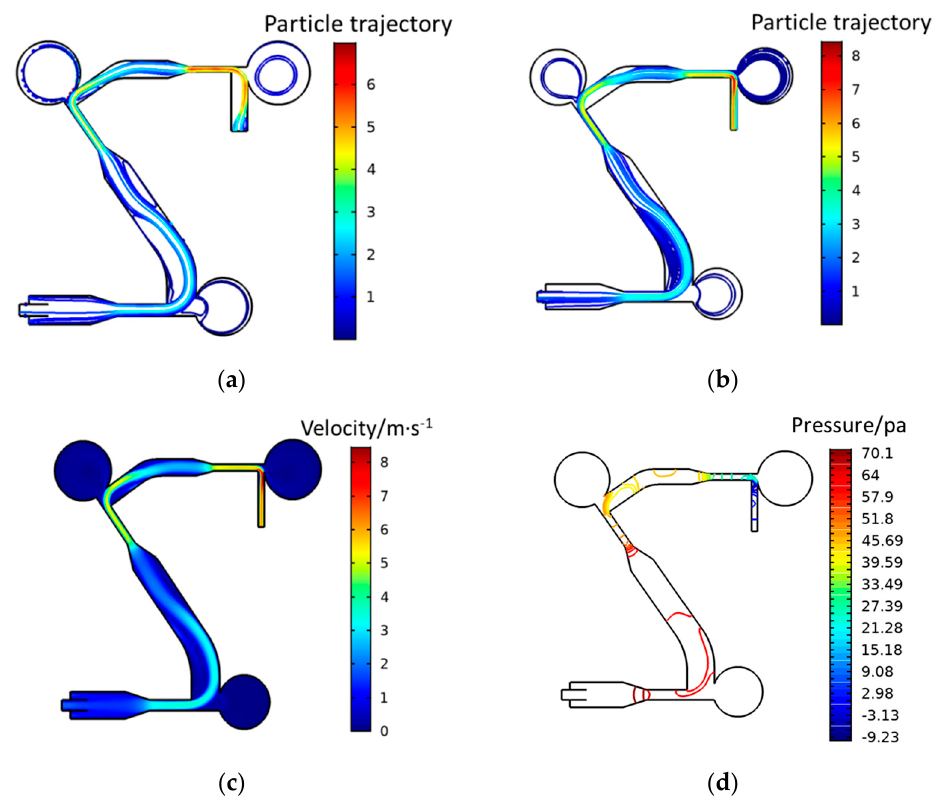
Figure 3. Simulation results of the microfluidic chip. ( a ) 4 µm particle trajectory, ( b ) 10 µm particle trajectory, ( c ) speed distribution, ( d ) pressure distribution.